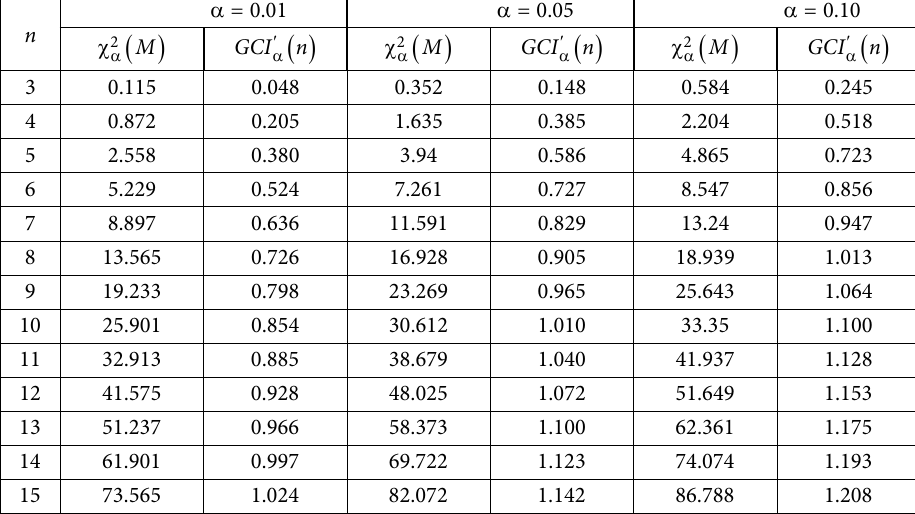
Table 3. Dynamic thresholds of GCI for 3- to 15-order PCMs at different significance